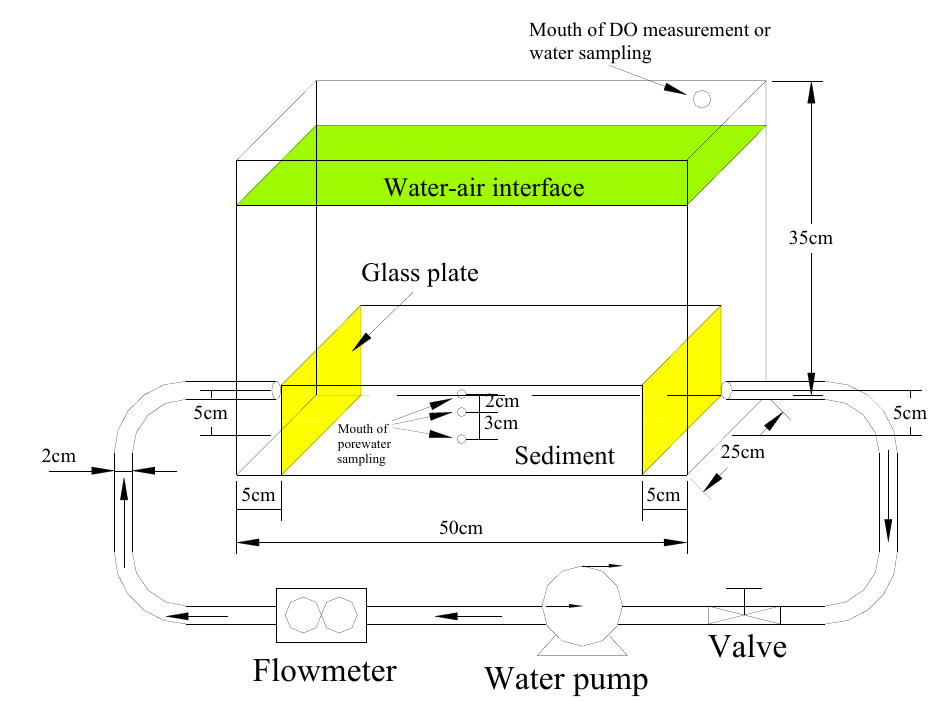
Figure 1. Illustration of the experimental apparatus.